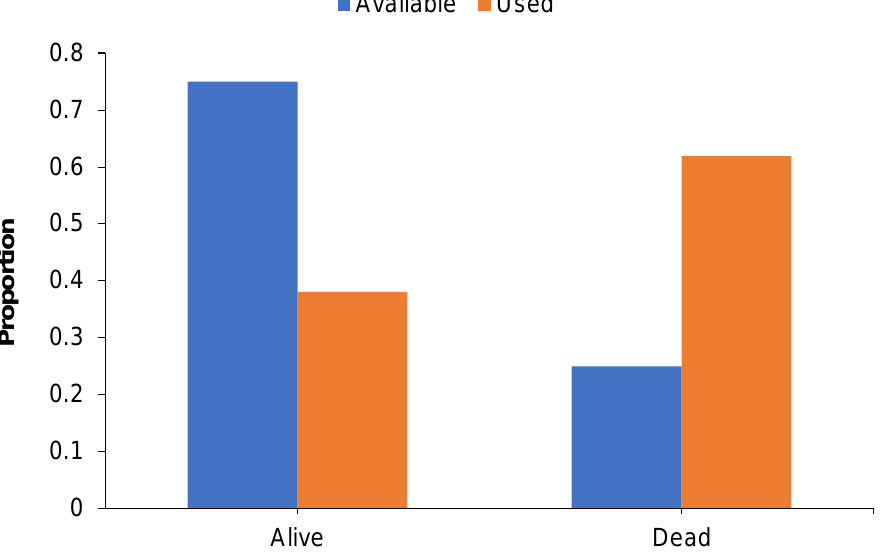
Figure 3. Column graph illustrating the proportion of roost (used) and locally available trees (>10 cm dbhob) represented by living and dead trees in the AWC site, Central Pilliga. Most characteristics of roost trees differed significantly from locally available trees, with the exception of the senescence score (Figure 4a–e). The diameter of trees used for roosting was relatively small (~23 cm dbhob) but was significantly larger than locally available (~18 cm dbhob) trees irrespective of whether they were living ( W = 107, p = 0.044, n = 16) or dead ( W = 269, p = 0.017, n = 26). Similarly, roost trees were taller (8–12 m) than locally available trees (7–10 m) irrespective of whether they were living ( W = 73.5, p = 0.007 n = 16) or dead ( W = 258.5, p = 0.009, n = 26). Canopy cover over roost trees was low (8%–9%) but was greater than cover of locally available trees (7%–8%) irrespective of whether they were living ( W = 50.5, p = 0.018, n = 16) or dead ( W = 99, p = 0.025, n = 26). Roost trees contained at least 1–2 hollows on average whereas no hollows were recorded for locally available trees irrespective of whether they were living ( W = 78, p = 0.002, n = 16) or dead ( W = 231, p < 0.001, n = 26). Senescence score for dead roost trees did not differ from locally available dead trees ( W = 6, p = 0.082, n = 26), as was the case for the living roost trees and locally available live trees ( W = 52, p = 0.082, n = 16). Roost tree characteristics for male and female N . corbeni were similar (male and female: dbhob= 22 ± 3 cm and 24 ± 2 cm; height = 9 ± 1 m and 11 ± 1 m; canopy cover = 8.7 ± 1.7% and 8.7 ± 1.3%; senescence score median = 6 and 6; hollow score median = 1 and